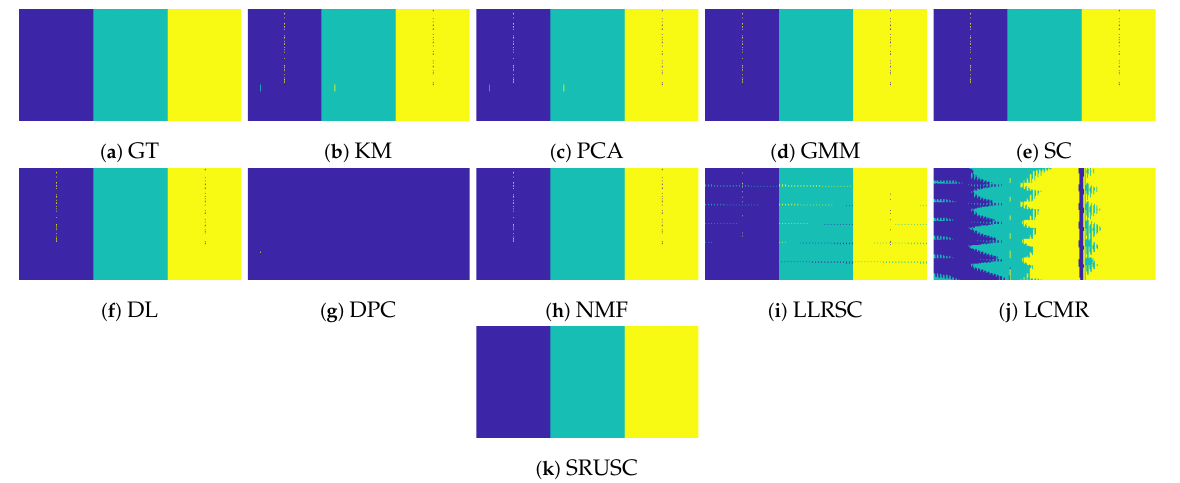
Figure 8. On the synthetic three cubes data set, only the proposed method is able to correctly label all data points. In particular, the spatial regularization is necessary to gain robustness to the noise introduced. Note, however, that the interpretation of the swapped points as noise relies on an assumption of spatial regularity in the pixel labels, which may not be reasonable in some contexts. While the swapped noise points were chosen randomly, repeated trials over which points were swapped did not change the numerical results